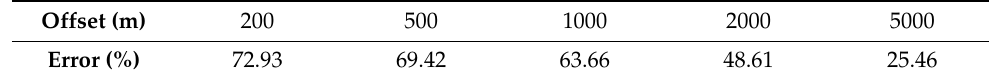
Table 1. Maximum relative errors for different offsets.